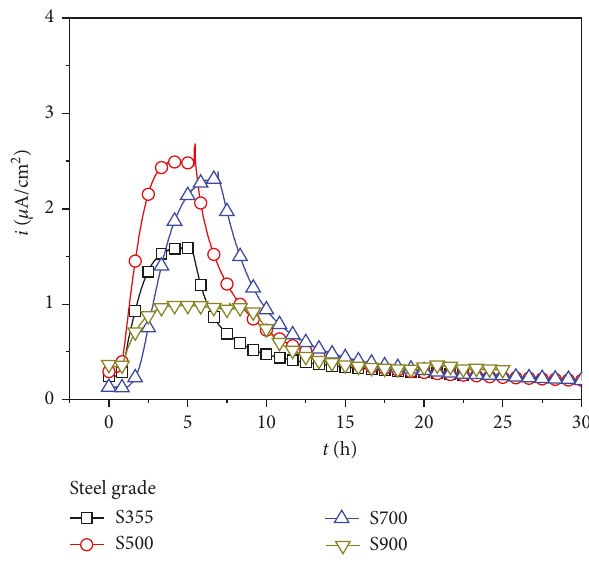
Figure 6: Permeation of hydrogen in 16.5% HCl for different steel grades with sample thickness 1